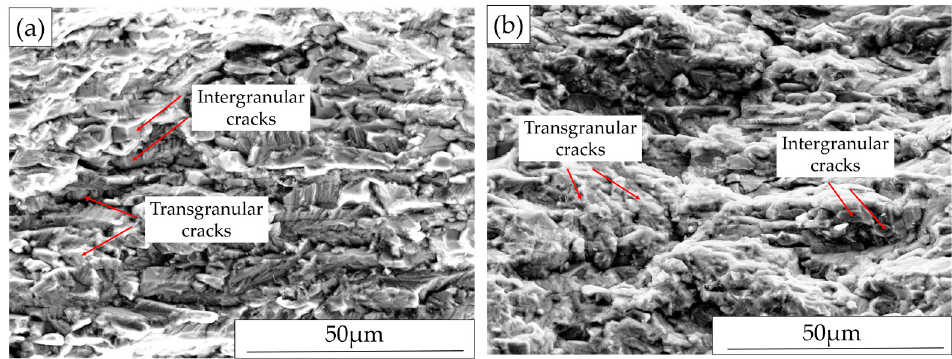
Figure 11. Fracture surface after exposure: ( a ) AD-TD specimen under 700 MPa loading; and ( b ) Ground-RD-RD specimen under 900 MPa loading.